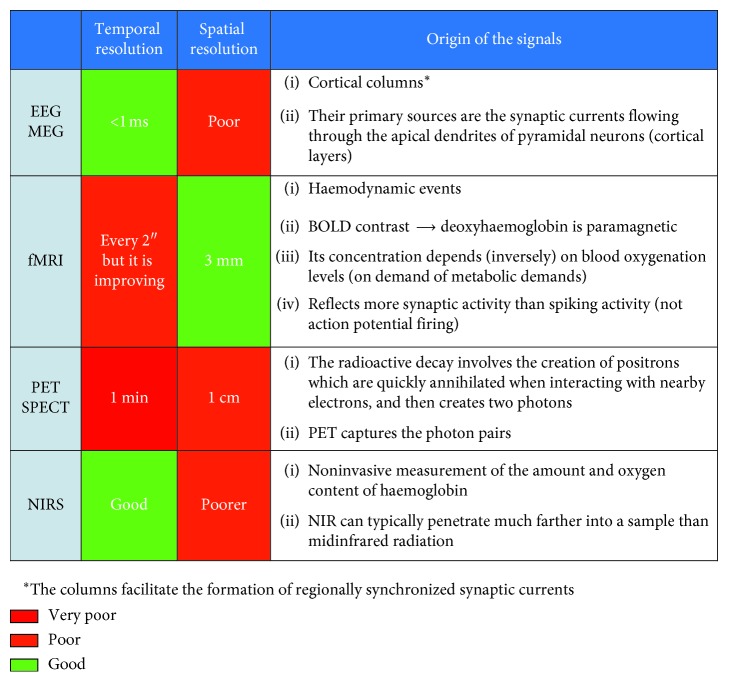
Temporal resolution, spatial resolution, and origin of the signals of the main neuroimaging technique [100].